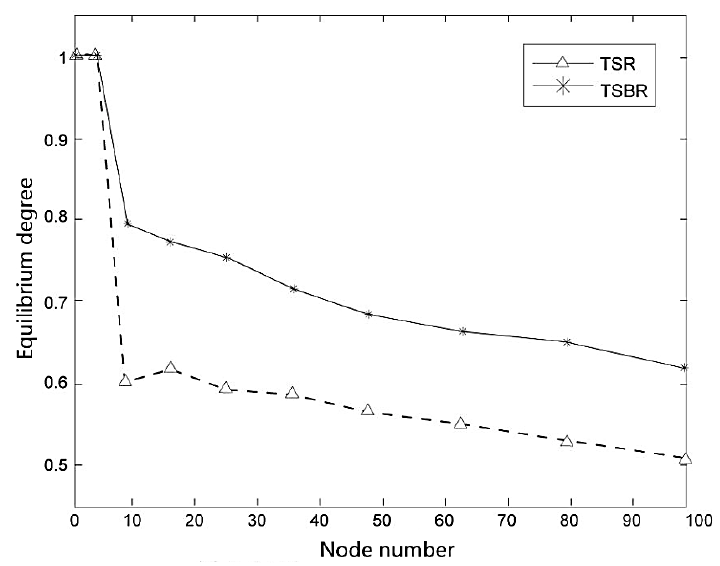
Figure 9. Equilibrium degree for different node